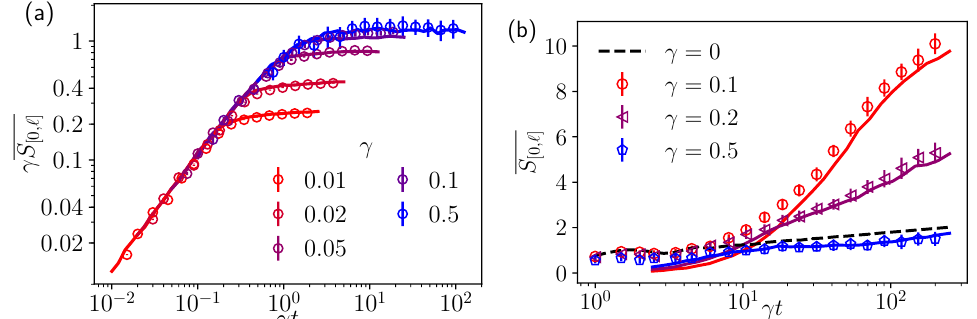
Figure 6: The evolution of EE in an interval [ 0, (cid:96) ] ( (cid:96) = 32 in an open chain of L = 512) from junction initial states. QT simulation results are plotted with markers and predictions from the Ansatz in solid curves. The colors indicate the value of γ